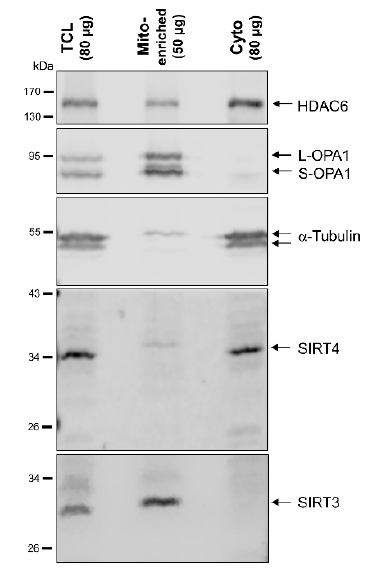
Figure 3. Subcellular fractionation analysis of endogenous SIRT4 and SIRT3 protein levels in HEK293 cells. Total cell lysates (TCL; 80 µ g) and the respective mitochondria enriched (Mito-enriched; 50 µ g) and cytosolic (Cyto; 80 µ g) fractions were subjected to immunoblot analysis. Subcellular marker proteins detected were OPA1 (long and short forms of OPA1; mitochondria), α -tubulin (cytoplasm), and HDAC6 (predominantly cytoplasmatic localization).